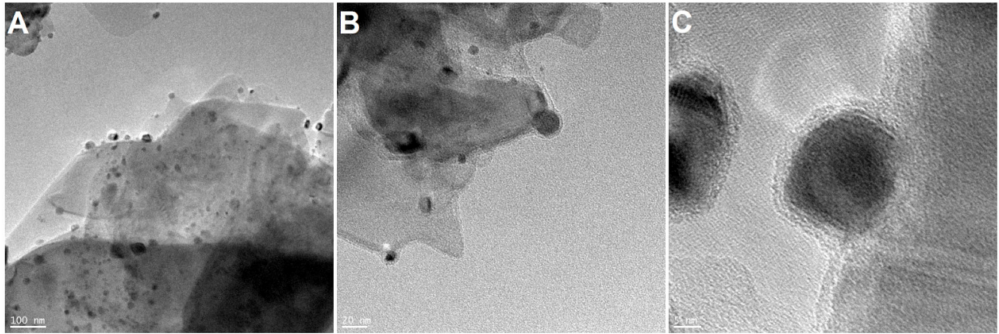
Figure 3. TEM images of MoS 2 / Ni 2 O 3 nanoparticles ( A – C